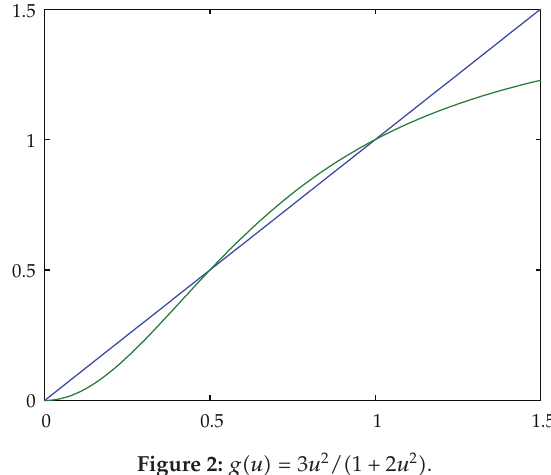
Figure 2: g (cid:6) u (cid:7) (cid:8) 3 u 2 / (cid:6) 1 (cid:5) 2 u 2 (cid:7)